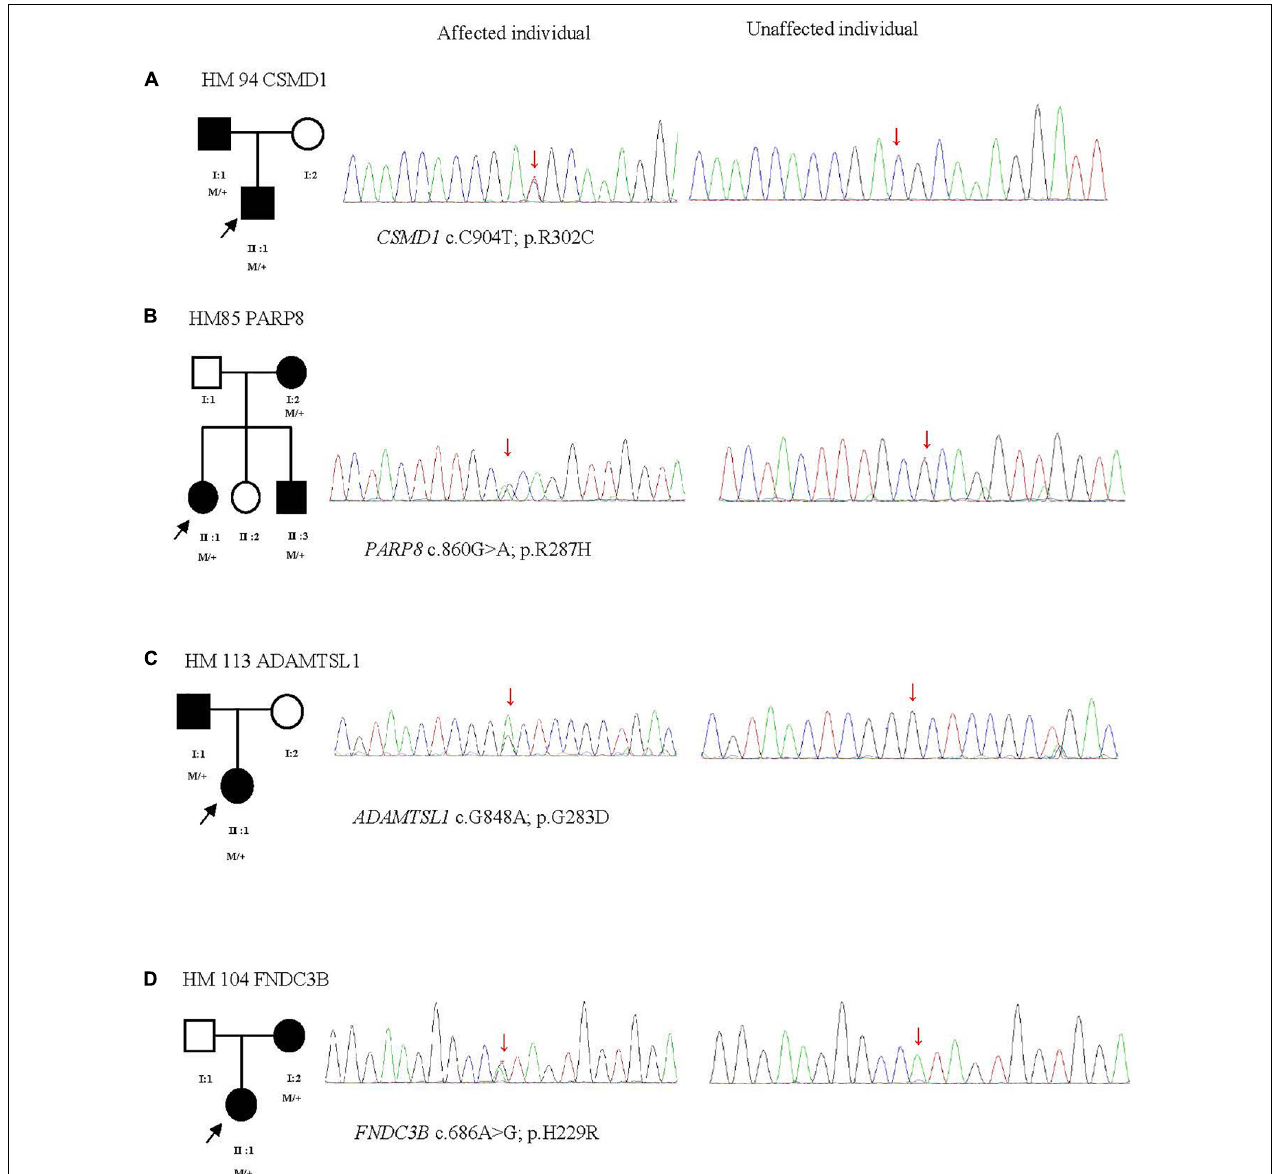
FIGURE 4 | Four potentially pathogenic variants detected in this study. The black arrow represents the patient. +, wild-type; M, mutation. From left to right: pedigree plots of mutations, sequences from affected individual with identified mutation, sequences from unaffected control (A–D) .